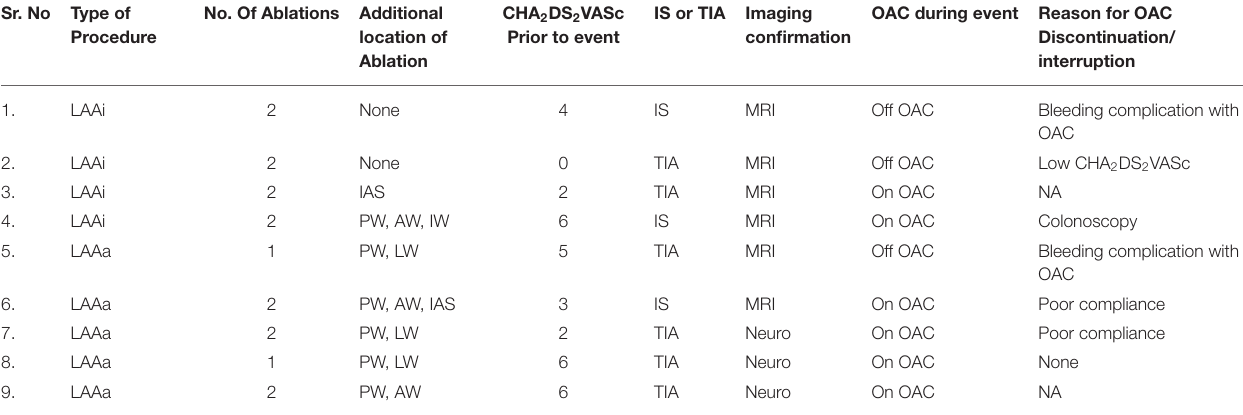
TABLE 3 | Ischemic stroke or transient ischemic attack events in patients with Left atrial appendage